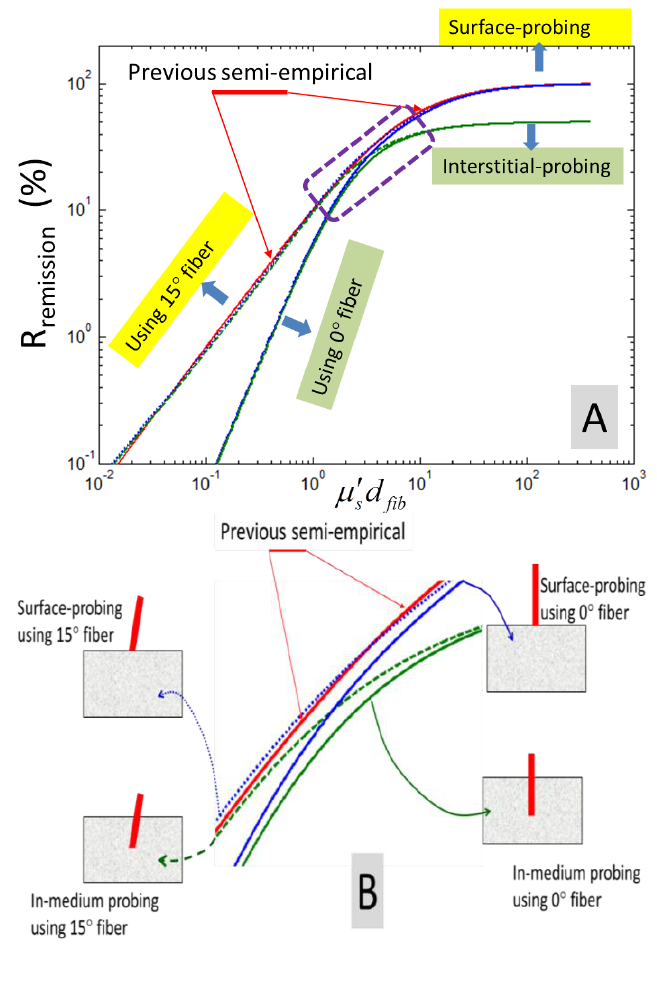
Figure 6. ( A ) Comparisons of analytically-derived ratios-of-remission (RoRs) corresponding to surface-probing or interstitial-probing using a straight- or angle-polished fiber probe, against semi-empirical RoR corresponding to an Henyey–Greenstein (HG) scattering phase function with g = 0.8. ( B ) The zoomed-up view of the plots enclosed by the dashed rectangle, as shown in (A). The red solid line with two arrows pointing at it corresponds to the “previous semi-empirical” model developed based on MC studies and experimental measurements from a scattering medium. The two other solid lines correspond to using a straight-polished fiber in either in-medium probing or surface-probing configurations. The dashed line corresponds to using a 15° angle-polished fiber in in-medium probing configuration, and the dotted line is the surface-probing configuration. The values corresponding to in-medium probing and surface-probing with the fiber of the same tip geometry merge at smaller values of the dimensionless reduced scattering coefficient. The values correspond to a straight-polished fiber and a 15° angle-polished fiber in the same condition of fiber placement with the medium converging at higher values of the dimensionless reduced scattering